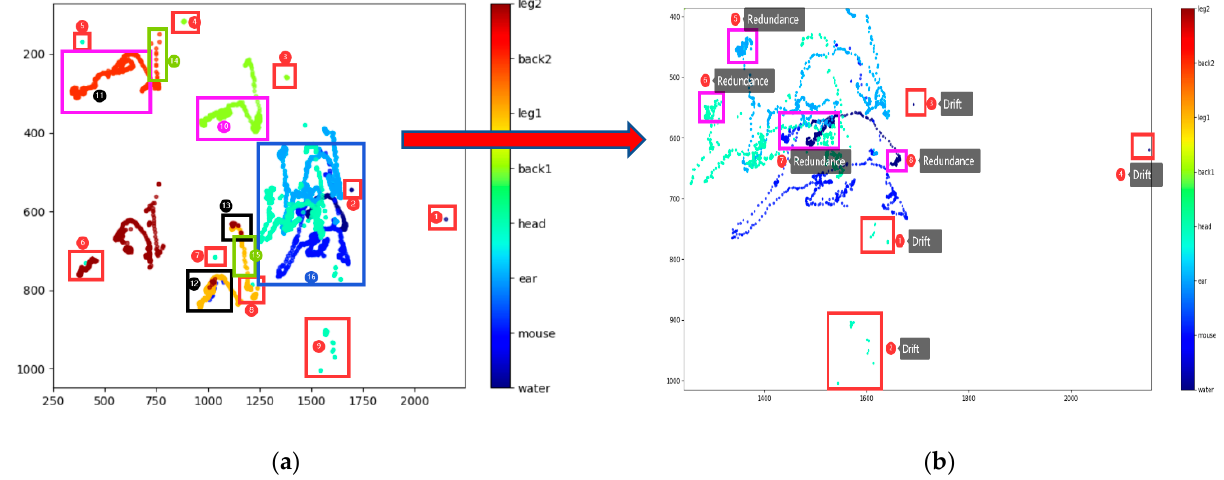
Figure 15. Abnormal trajectory analysis. ( a ) Overall abnormal trajectory; ( b ) local abnormal trajectory.